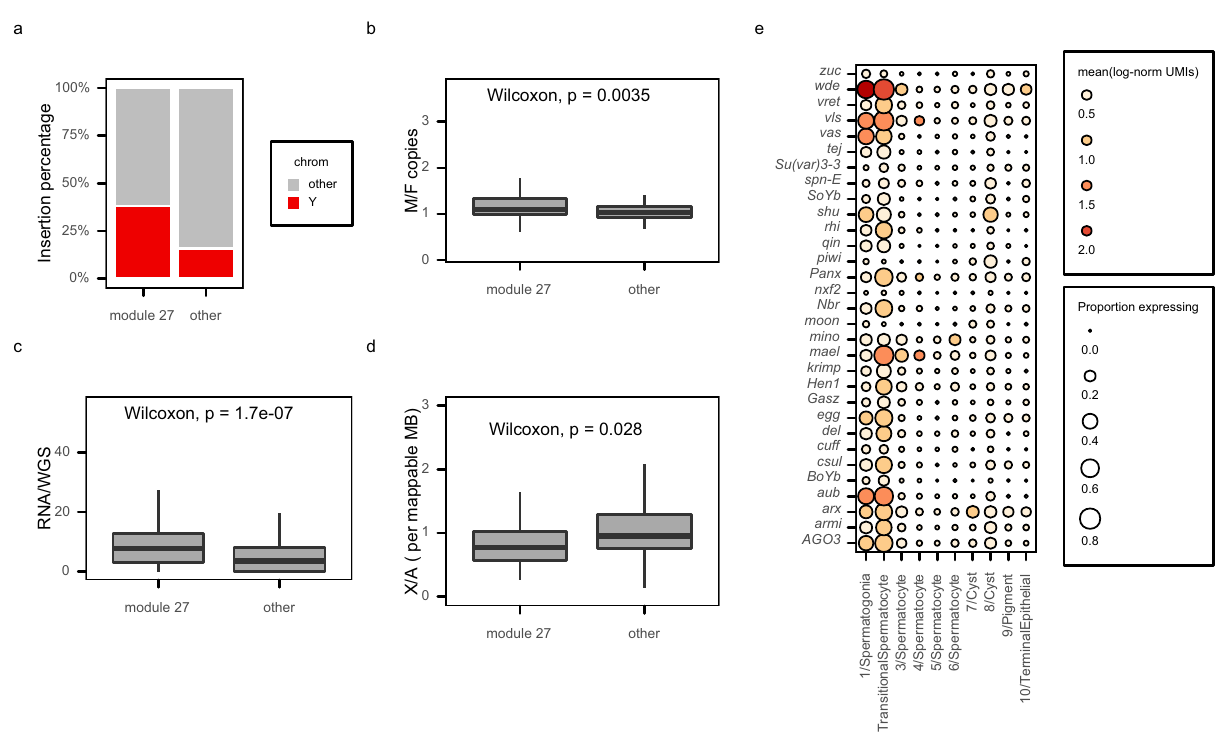
Fig. 5 Module 27 Transposable elements are enriched on the Y chromosome. a A higher proportion of module 27 transposable element (TE) insertions are found on the Y chromosome compared to TEs in other modules. Chi-square test, one-sided P = 2.29e − 292. To better estimate Y-linked insertions despite the incomplete Y-assembly in the reference sequence, insertions were mapped from a heterochromatin-enriched assembly (see Methods). b Ratios of male and female copy numbers for individual TEs estimated from w1118 whole-genome sequencing (WGS) coverage. One male and one female sample were sequenced and used in ratio calculation. Module 27 TEs are present at higher copy number in the male genome. N = 73 module 27 TEs, 72 other module TEs. Wilcoxon rank-sum test, two-sided P = 0.0035. c Allele speci fi c analysis of TE expression (see Methods) shows that Y-linked copies of module 27 TEs are overexpressed relative to their DNA copy number and this overexpression is signi fi cantly larger than that of TEs in other modules. N = 58 module 27 TEs, 32 other module TEs. Wilcoxon rank-sum test, two-sided P = 1.7e − 07. d Boxplot showing the ratios of X-linked versus autosomal polymorphic insertions per mappable megabase for each TE in the TIDAL- fl y database with a corresponding TE in this analysis. Module 27 TEs are depleted from the X chromosome compared to other TEs with polymorphic insertions. N = 61 module 27 TEs, 38 other module TEs. Wilcoxon rank-sum test, P = 0.028. For all boxplots, midline represents median, box represents interquartile range (IQR), and whiskers extend >1.5 IQR from the upper or lower quartile. e Dot plot shows expression of selected piRNA pathway genes. Color of each dot corresponds to mean normalized and log-transformed expression within cell clusters. Dot size corresponds to the proportion of cells in each cluster expressing the marker. Source data are provided as a Source Data